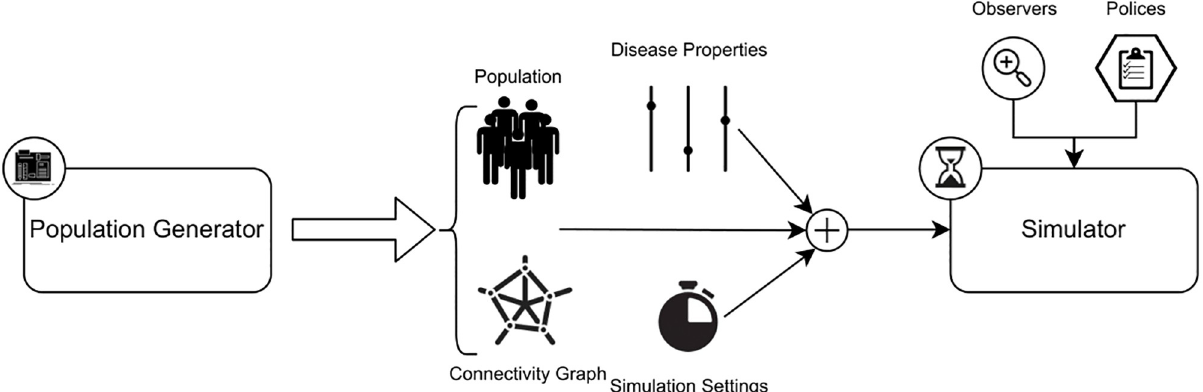
Fig 1. The pipeline of Pyfectious. The population generator creates the individuals and assigns them their roles to establish the connectivity graph. The connectivity graph, the disease properties, the clock, and the simulation settings are then fed to the simulator to create the time evolution of the disease. Furthermore, the observers and the policies are provided to the simulator in order to log data and make specific alternations to the simulation to emulate real-world epidemic control